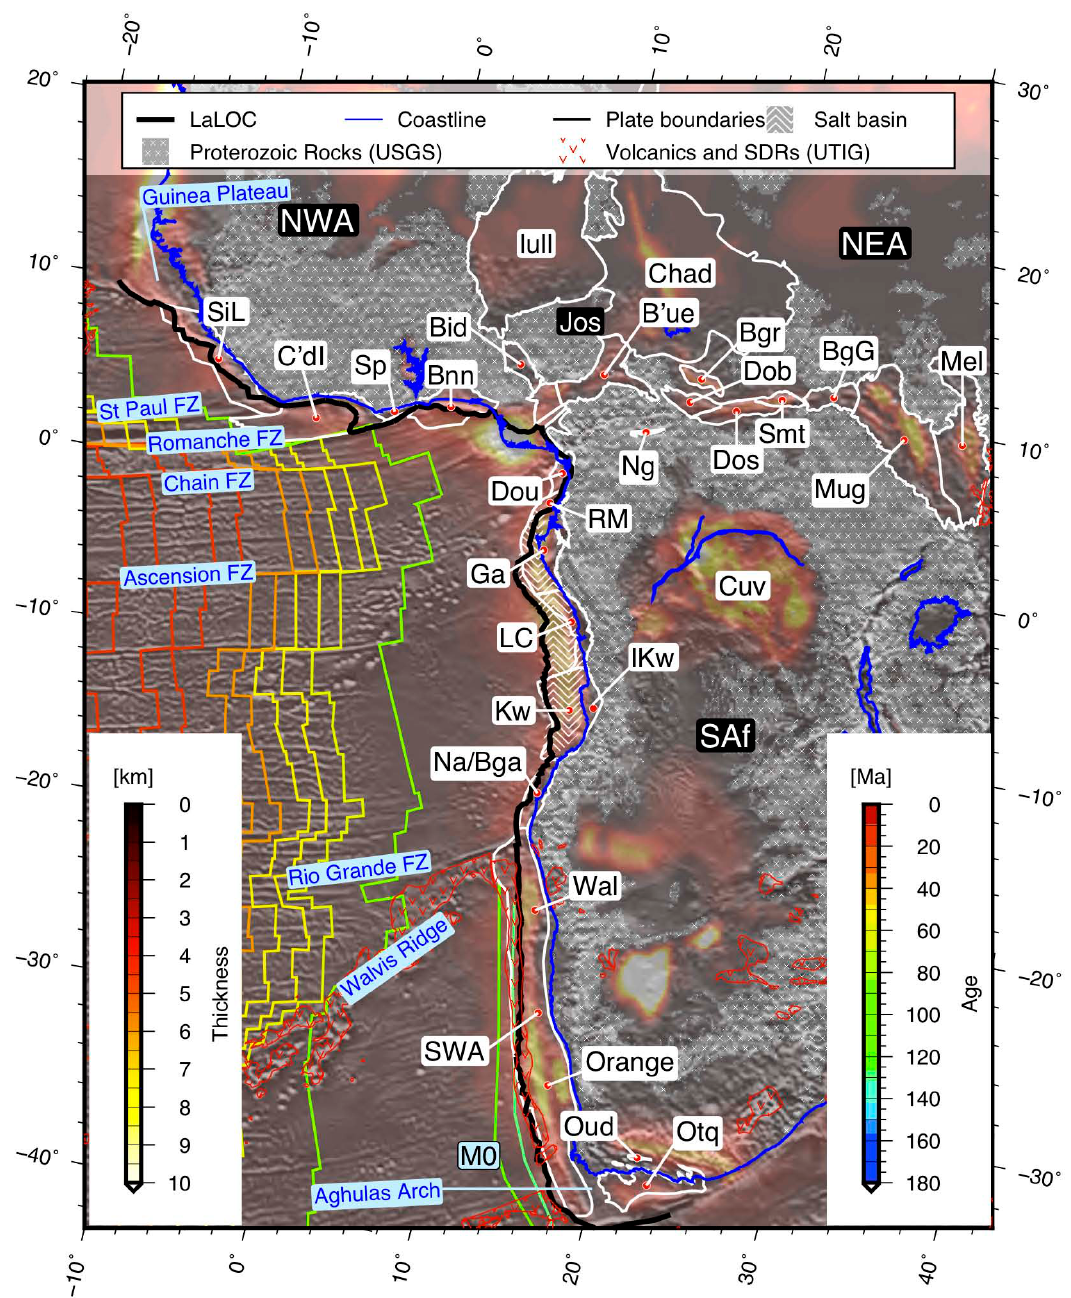
Fig. 5. Oblique Mercator map of present-day Africa, with onshore topography (ETOPO1; Amante and Eakins, 2009), offshore free-air gravity (Sandwell and Smith, 2009), both greyscale, and gridded sediment thickness (Exxon Production Research Company, 1985) superimposed. Map legend: LaLOC – landward limit of oceanic crust, Proterozoic rocks and Mesozoic extrusive rocks based on United States Geological Survey (2012). Seaward-dipping reflectors (SDRs) based on UTIG PLATES open data (https://www.ig.utexas.edu/research/projects/plates/ data.htm). White polygons indicate sedimentary basins (N to S): SiL – Sierra Leone marginal; C’dI – Cˆote d’Ivorie marginal; Sp – Saltpond; Bnn – Benin; Bid – Bida; Iull – Iullememmden; Chad – Chad Basin; B’ue – Benue Trough; Bgr – Bongor Trough; Dob – Doba; Dos – Doseo; BgG – Banggara Graben; Mel – Melut; Mug – Muglad; Smt – Salamat; Ng – Ngaoundere; Dou – Douala; RM – Rio Muni; Ga – Gabon coastal; Cuv – Cuvette central; LC – lower Congo; Kw – Kwanza/Cuanza; IKw – inner Kwanza; Na/Bga – Namibe/Benguela; Wal – Walvis; SWA – southwest African marginal; Orange – Orange; Oud – Oudtshoorn; Otq – Outeniqua. Fz: oceanic fracture zone. Coloured lines are oceanic isochrons from M¨uller et al. (2008); M0 – M0 magnetic anomaly (120.6ma). Plates and sub-plates: NWA – northwest Africa; NUB – Nubia/northeast Africa; JOS – Jos Plateau sub-plate; and SAf – austral Africa. Origin of map projection at 10 ◦ S, 5 ◦ W; azimuth of oblique equator 80 ◦